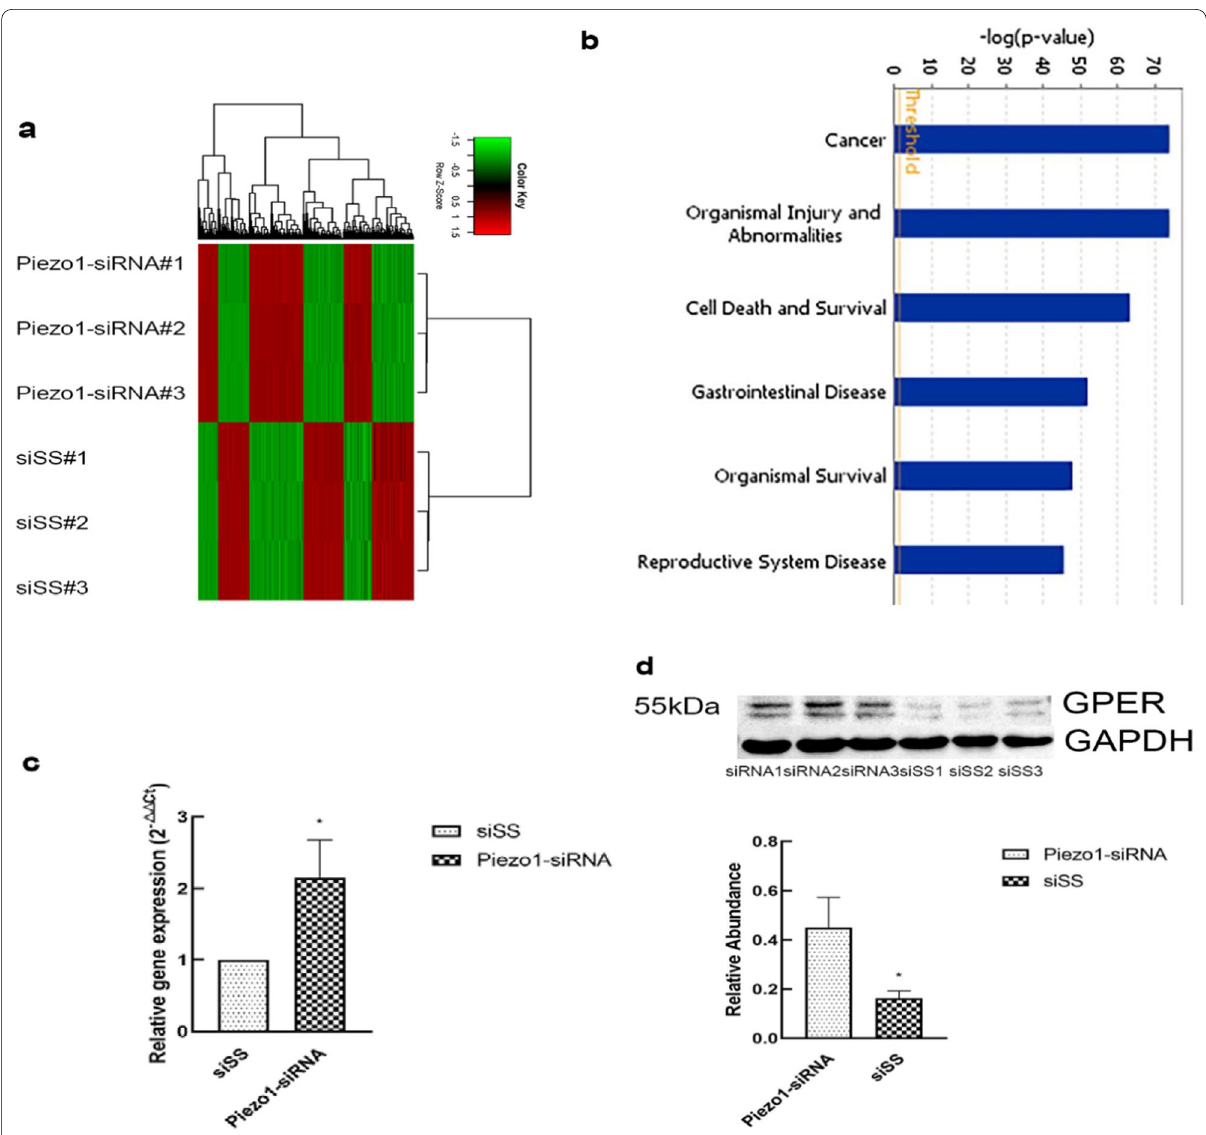
Fig. 1 GPER is upregulated in chondrocytes exposed to mechanical stress after Piezo1 silencing. a Heatmap of differential gene expression values upon Piezo1 silencing in chondrocytes exposed to mechanical stress. b Disease and function analysis of differential gene expression values upon Piezo1 silencing in chondrocytes exposed to mechanical stress. c RT-qPCR analysis of GPER genes in Piezo1-silenced chondrocytes compared with non-silenced chondrocytes (n 3). d Protein expression of GPER in Piezo1-silenced chondrocytes compared with non-silenced chondrocytes = (n 3). All data are presented in mean SD *P < 0.05, compared with non-silenced = ±